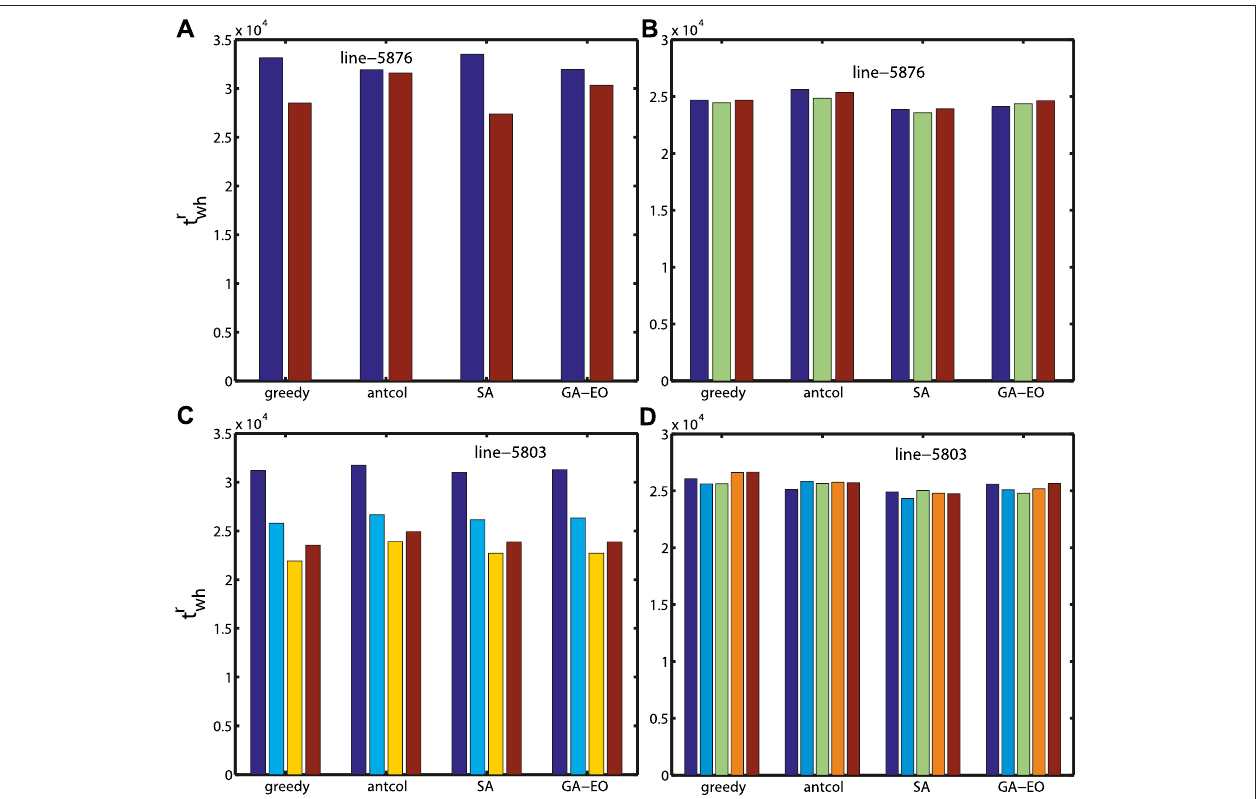
FIGURE 5 | (color online) Working hours t wh for different numbers of inspection teams by using our framework without swap. (A,B) Line-5876 with k = 2 and k = 3 and (C,D) line-5803with k =4, k =5.Theperturbationparameter p issetto0.05forthegreedyalgorithm.Becausetheworkinghoursarenotwell-balancedforline-5803 when k = 4, so the result of k = 3 for line-5803 is not shown in this fi gure.